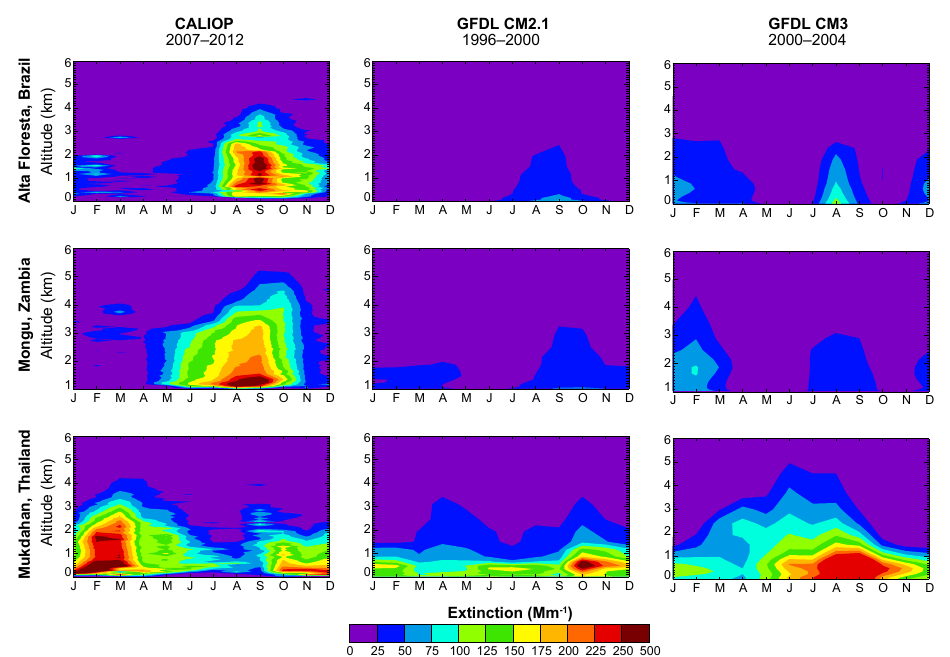
Figure 10. Extinction coefficients (Mm − 1 ) from CALIOP and the models for three biomass burning sites. CALIOP extinctions measured at 550nm; model (CM2.1: middle panels, CM3: right panels) parameters calculated at 550nm.